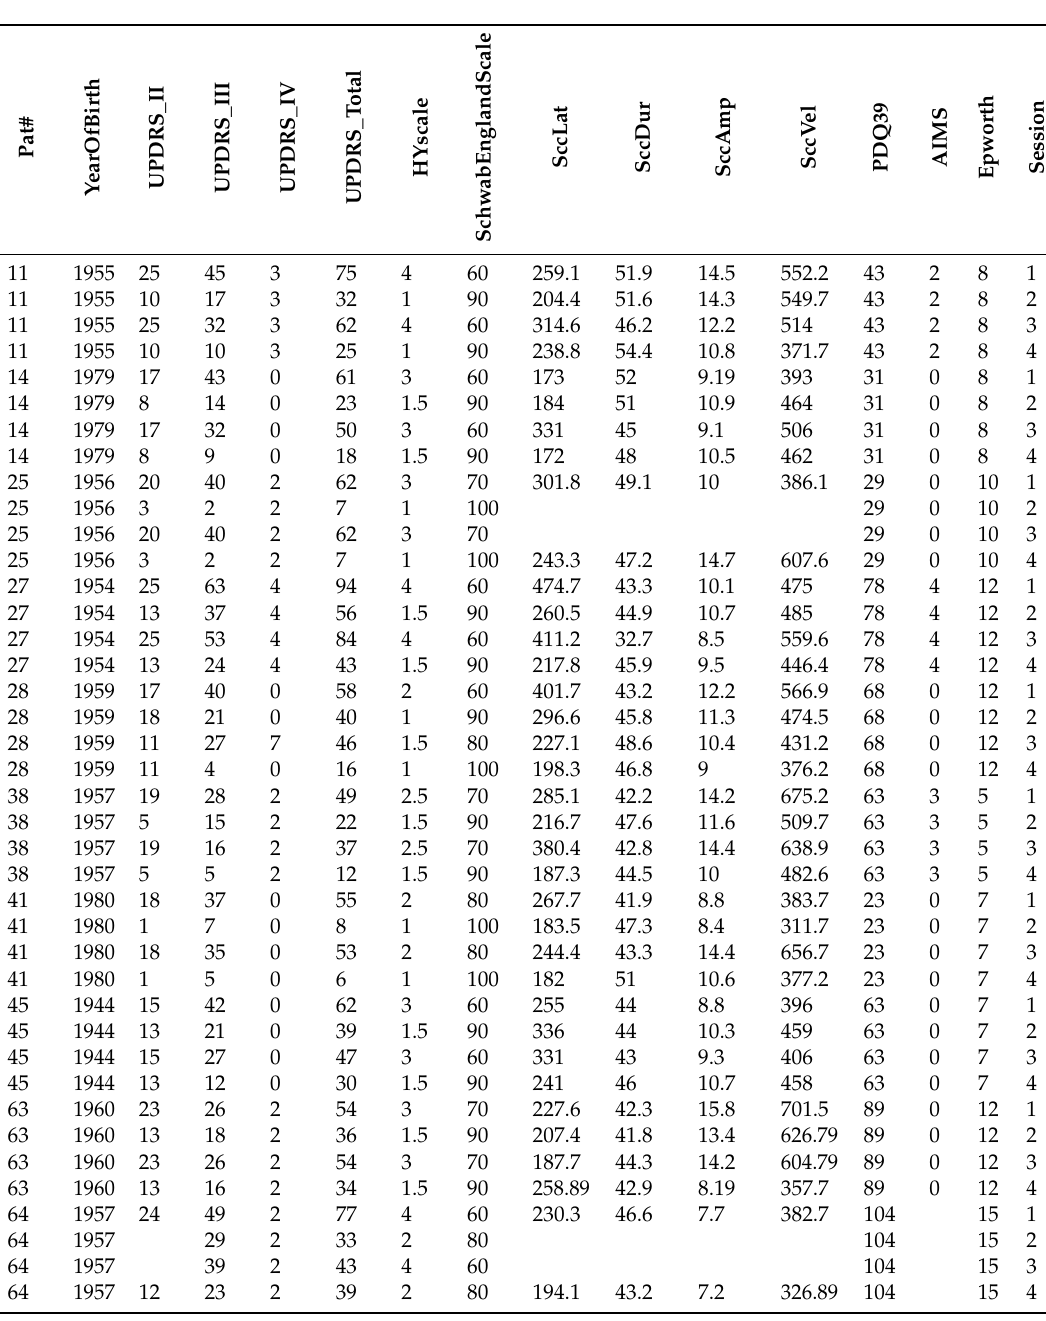
Table A1. Input data for our